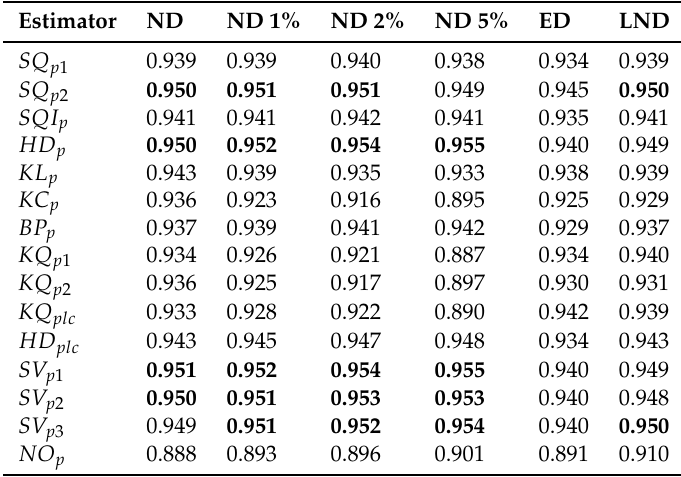
Table 3. Coverage probabilities for nonparametric Limits of Agreement ( n = 80). Bold figures indicate coverage probabilities exceeding the nominal level of